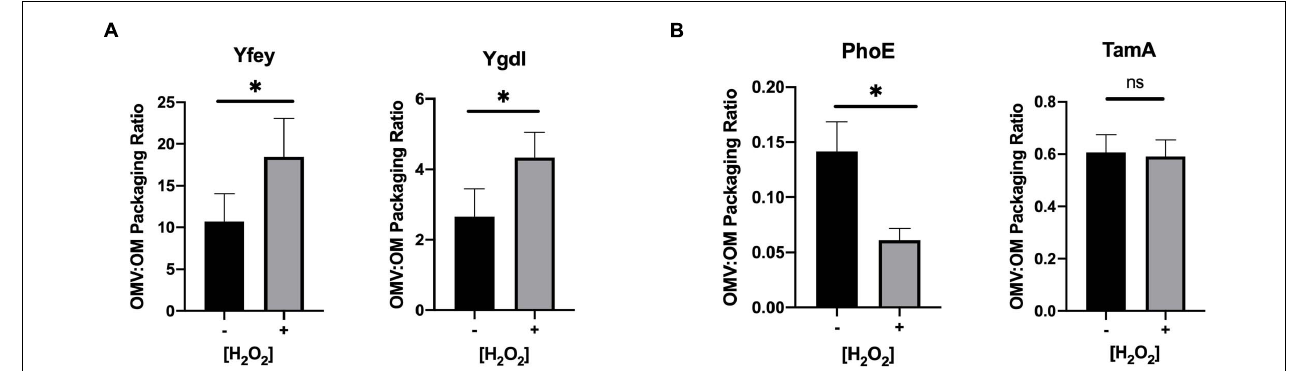
FIGURE 4 | Validation of preferential packaging of lipoproteins into OMVs upon oxidative stress. Packaging ratios (OMV:OM) were calculated from the detection of tagged OM lipoproteins (A) or integral OM proteins (B) by quantitative immunoblotting of OM and OMV preparations from untreated (–) and 3 h H 2 O 2 -treated (+) BL21 constructs. YfeY ( n = 8), YgdI ( n = 4), PhoE ( n = 6), TamA ( n = 6). Error bars are SEM. P -values according to the Student’s t -test: ∗ p ≤